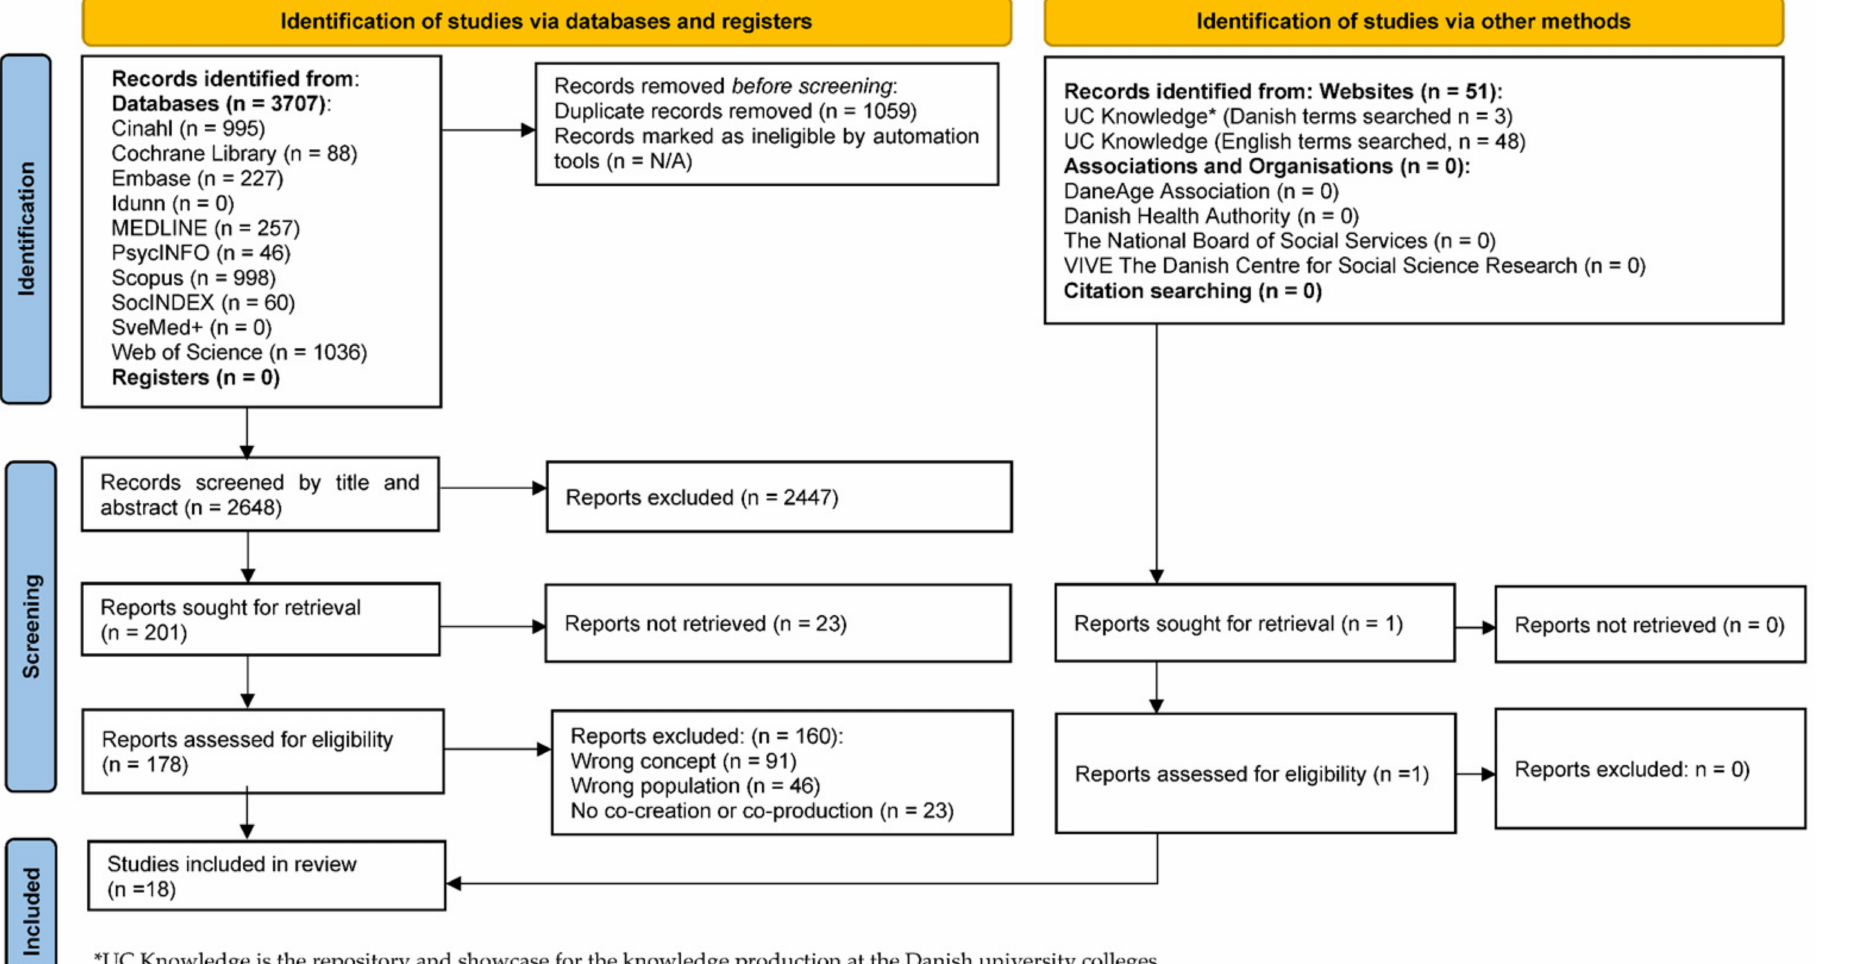
Figure 1. PRISMA flow chart illustrating the study selection process